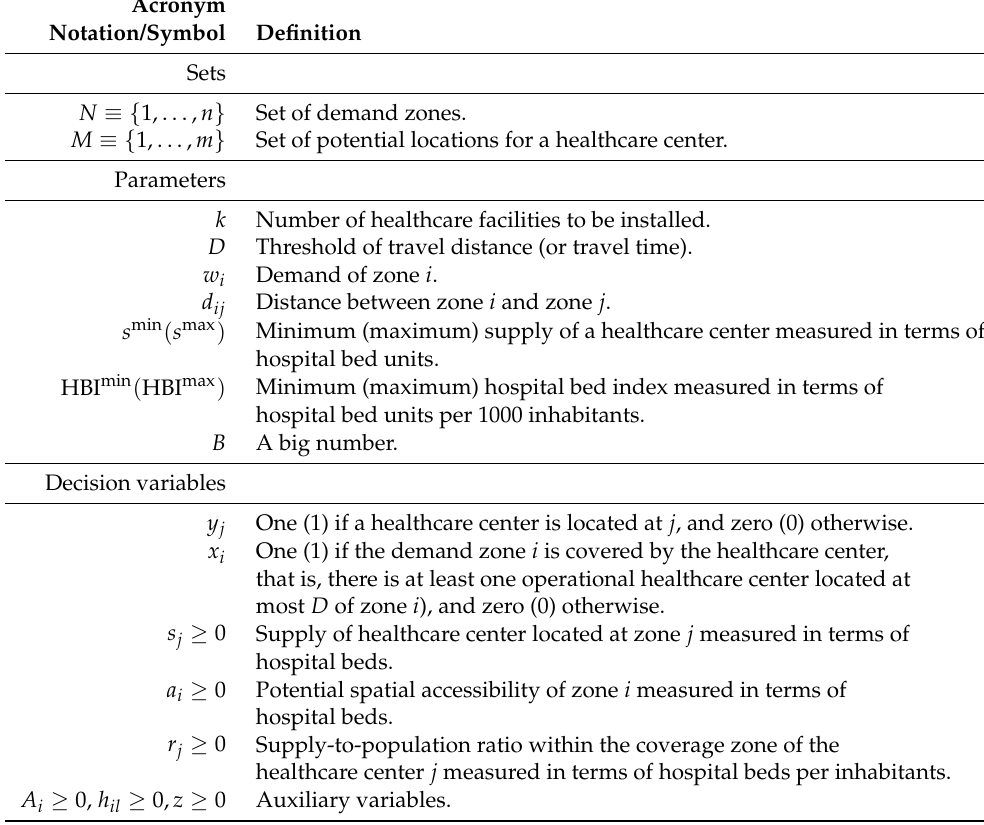
Table 1. Acronyms, notations and